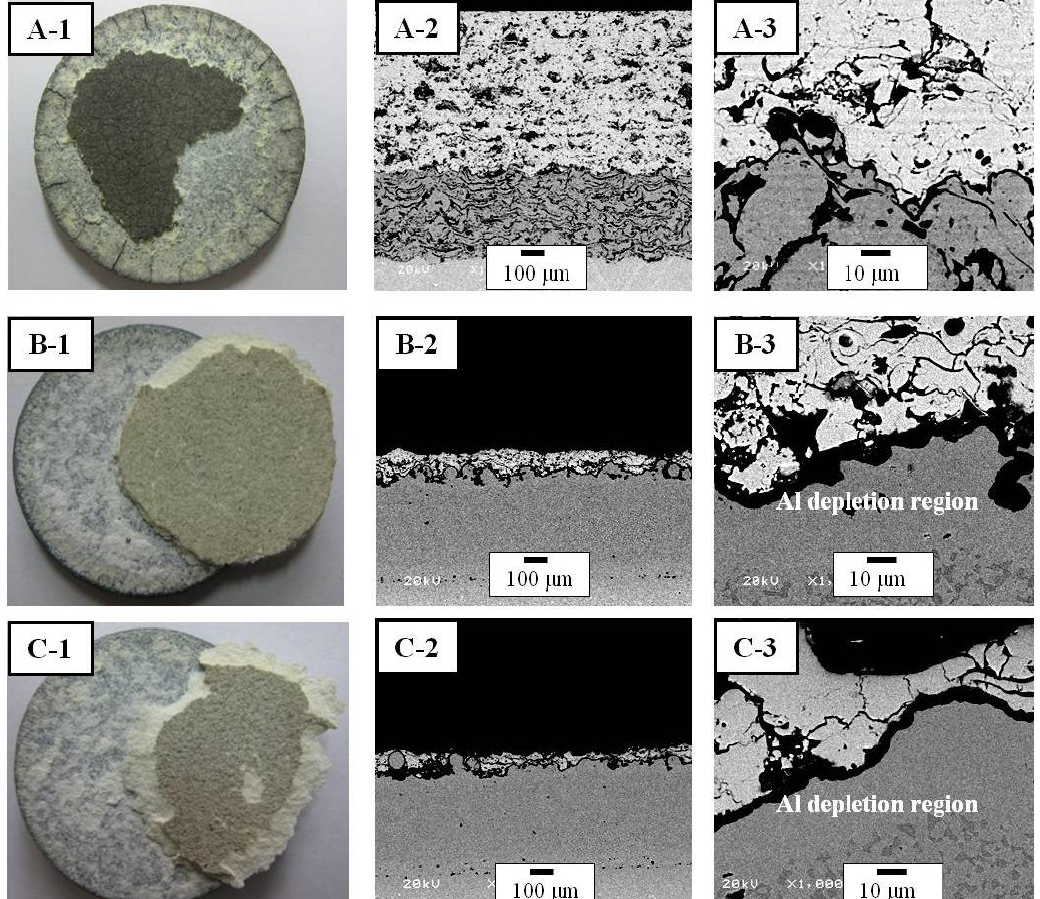
Figure 6. Surface micrographs and cross-sectional microstructures of TBCs after TS tests: ( A ) TBC with APS bond coat; ( B ) TBC with HVOF bond coat; and ( C ) TBC with LPPS bond coat. Each number indicates surface micrographs, cross-sectional interface microstructures between the top and bond coats, and high magnification interface microstructures,